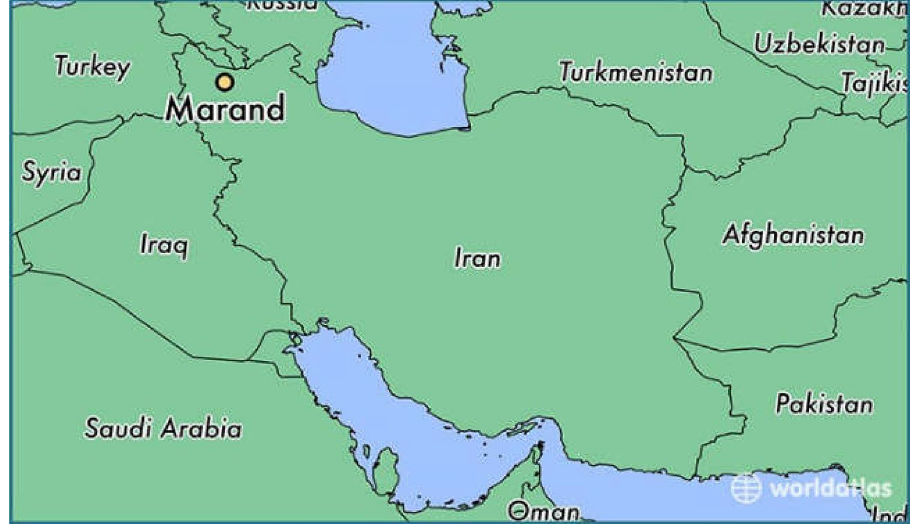
Fig. 1 The location of the CSG check dam in the Marand